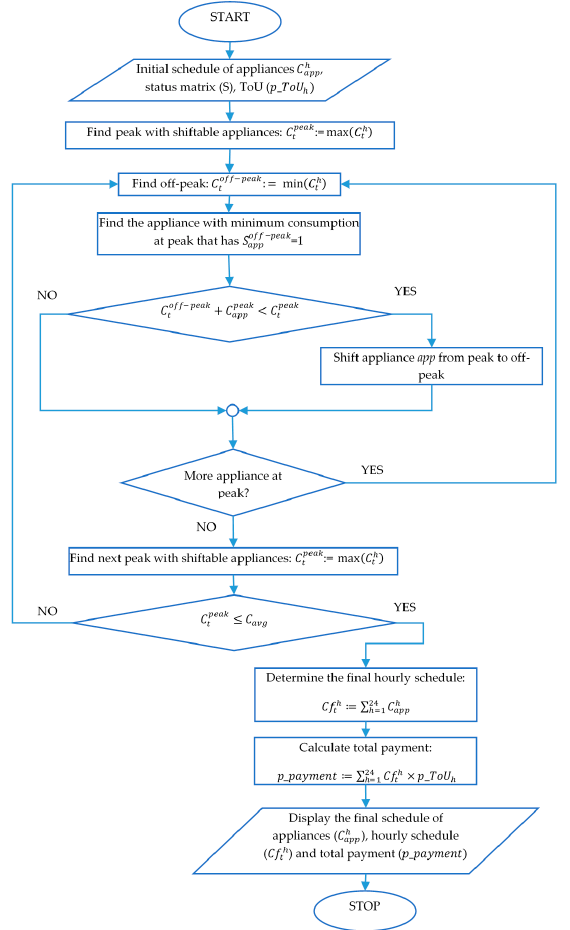
Figure 6. Flowchart of the shifting Algorithm 2.